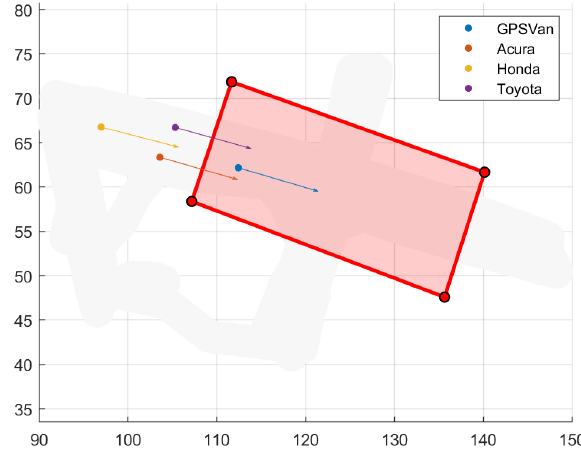
Figure 5. Case study 1: vehicle starting configuration.